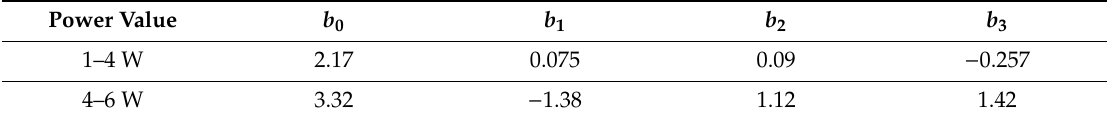
Table 4. Summary of regression coe ffi cient